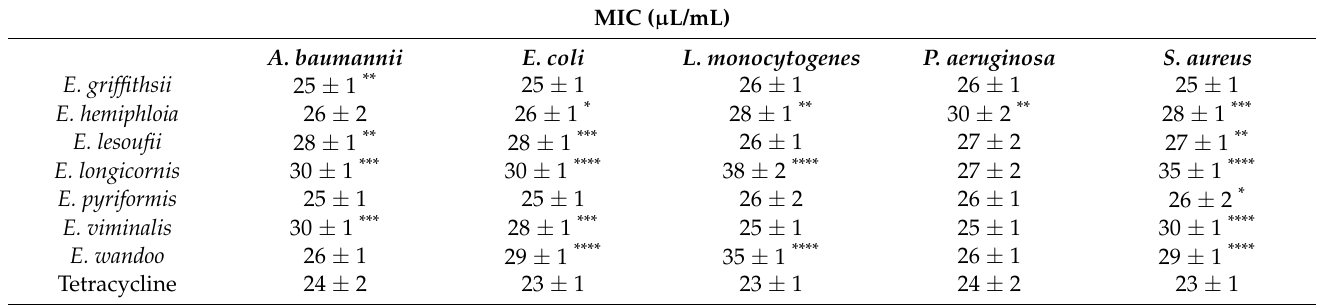
Table 3. MIC ( µ L/mL) of the EOs required to inhibit the growth of A. baumannii , E. coli , L. monocyto- genes, P. aeruginosa and S. aureus . Tetracycline was used as a positive control. MIC ( µ